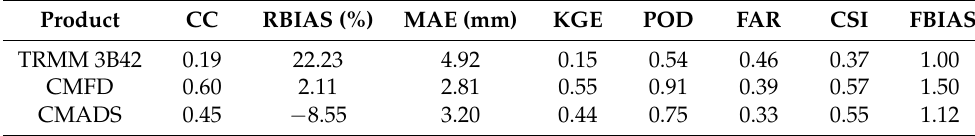
Table 6. Evaluation indexes of the daily-scale precipitation accuracy for different precipitation